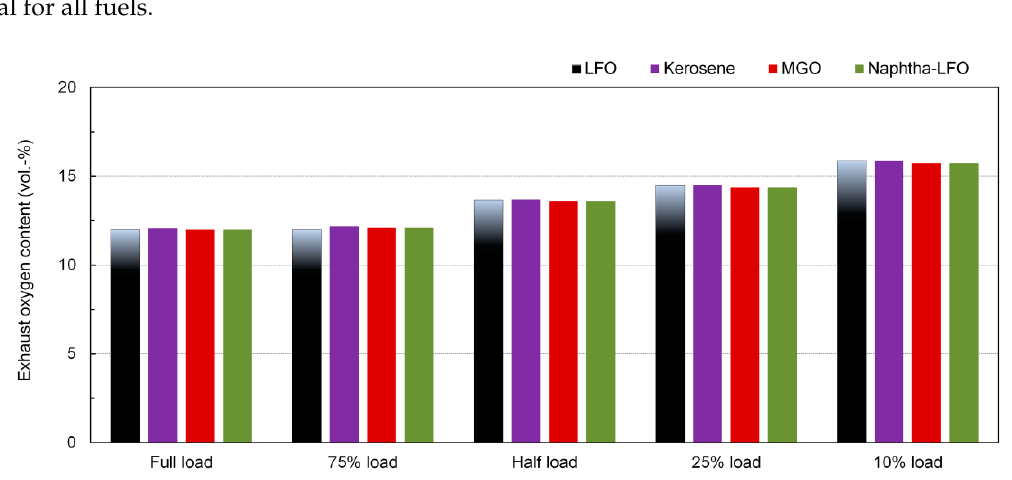
Figure 8. Dry exhaust oxygen content at different engine loads for studied fuels.